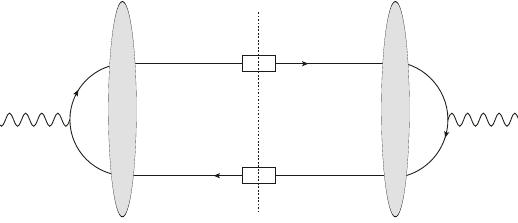
Figure 3 . Diagram of the LO process at cross-section level. The blob is the shockwave (we do not draw the coupling with the target for clarity) and the squares the FFs, see figure 2. The dashed line is to represent the integration over phase